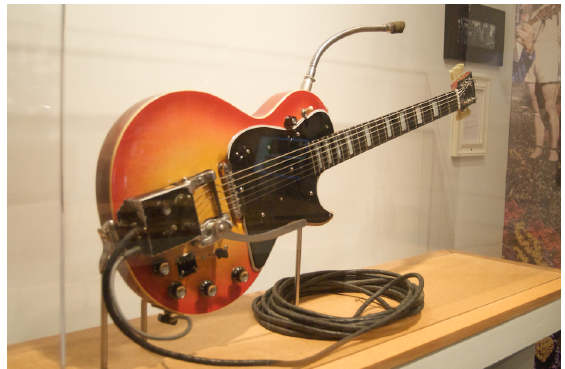
Figure 5. With a black control box (the Les Paulverizer ) mounted on a guitar, Les Paul was able to control tape machines during live performances. Photo c (cid:13) 2010 by Mark Zaputil (Zap Ltd. Music), used with permission.